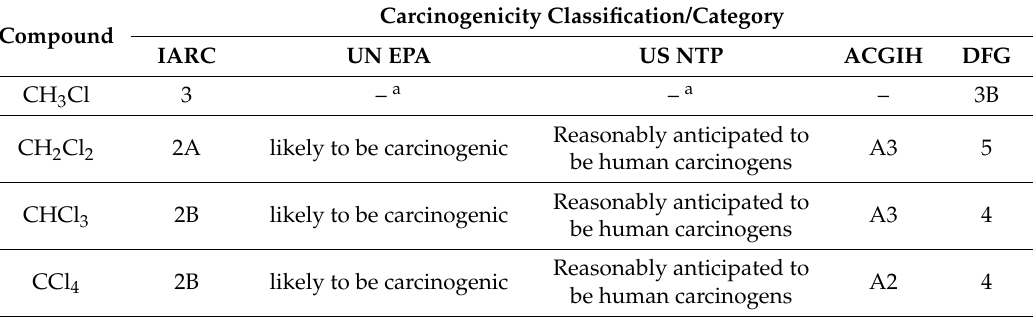
Table 4. Carcinogenicity classification of chloromethanes.